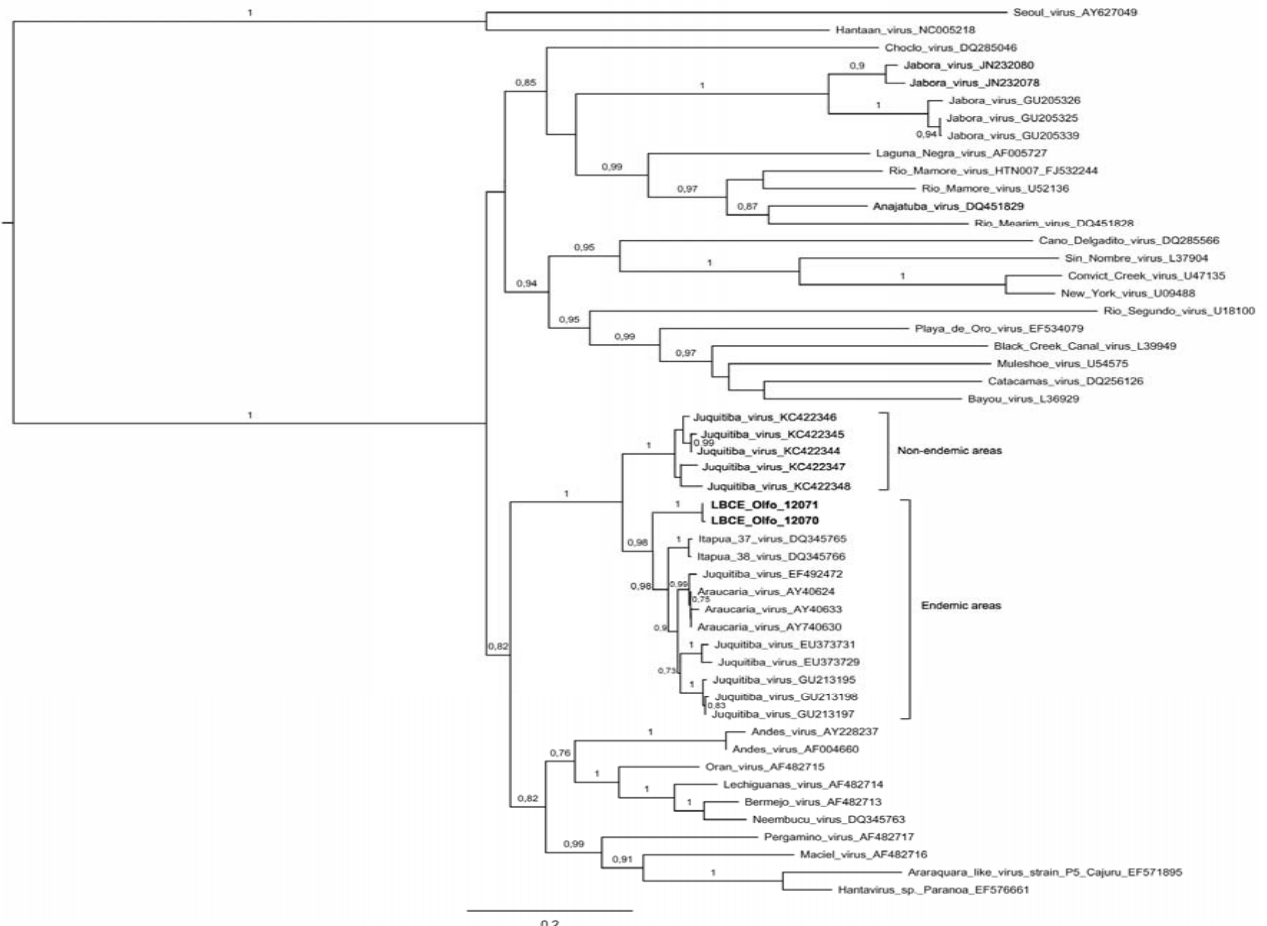
Figure 2. Phylogenetic relationships among hantaviruses based on a Bayesian analysis of genetic distances generated from comparisons of the nucleocapsid protein gene partial sequences (935 nt). The scale bar indicates a sequence divergence of 0.2. The numerical value at the node indicates the posterior probability (pp) replicates that supported the interior branch. The branch labels include GenBank ® accession number and viral species or strain (Access number: Genbank ® LBCE_Olfo_12070-KF913849,